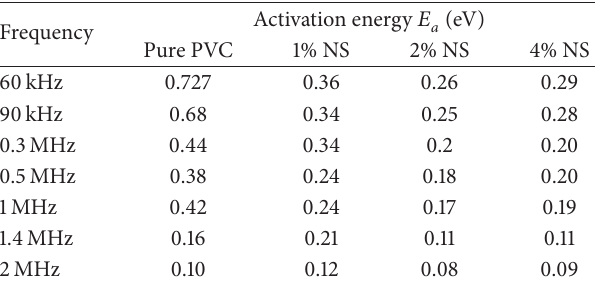
Table 2: Activation energies of pure PVC and PVC/ SiO 2 nanocom- posite films according to the Arrhenius relation within the temper- ature range of 300–370